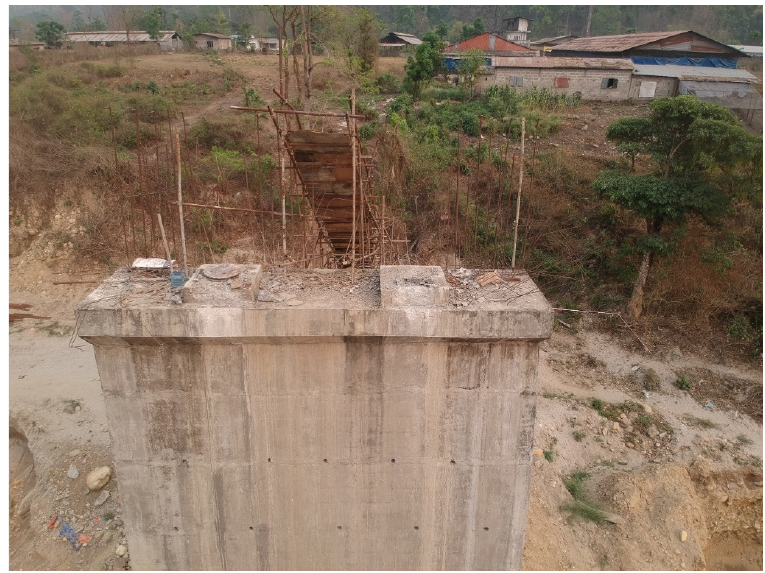
Figure 14. Bearing damage in Abutment-1 due to slippage of the slab before falling.